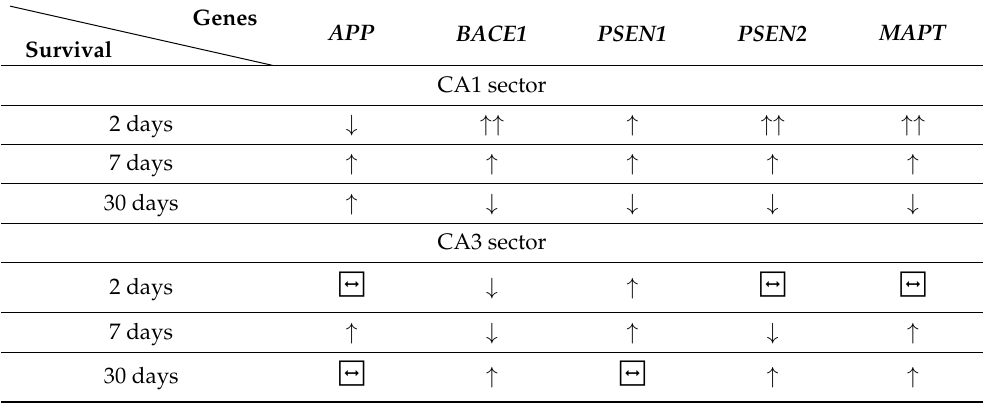
Table 1. Expression of genes associated with Alzheimer’s disease in CA1 and CA3 sectors in post- ischemic hippocampus.